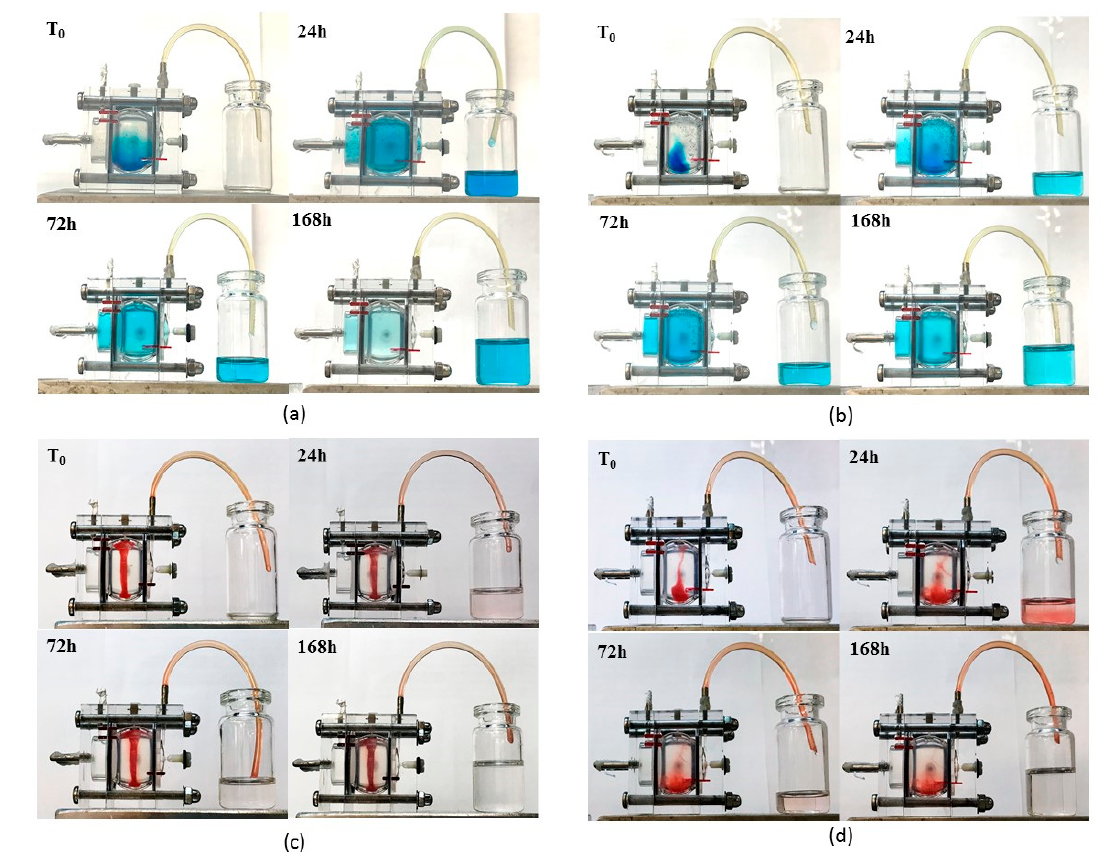
Figure 12. Brilliant Blue ocular cell diffusion and clearance from ( a ) 0.1% w/v in aqueous solution; ( b ) 0.1% w/v in 20% w/v PF127 aqueous solution; Sudan III ocular cell diffusion and clearance from ( c ) 0.1% w/v in SLN; ( d ) 0.1% w/v in S-TNH.